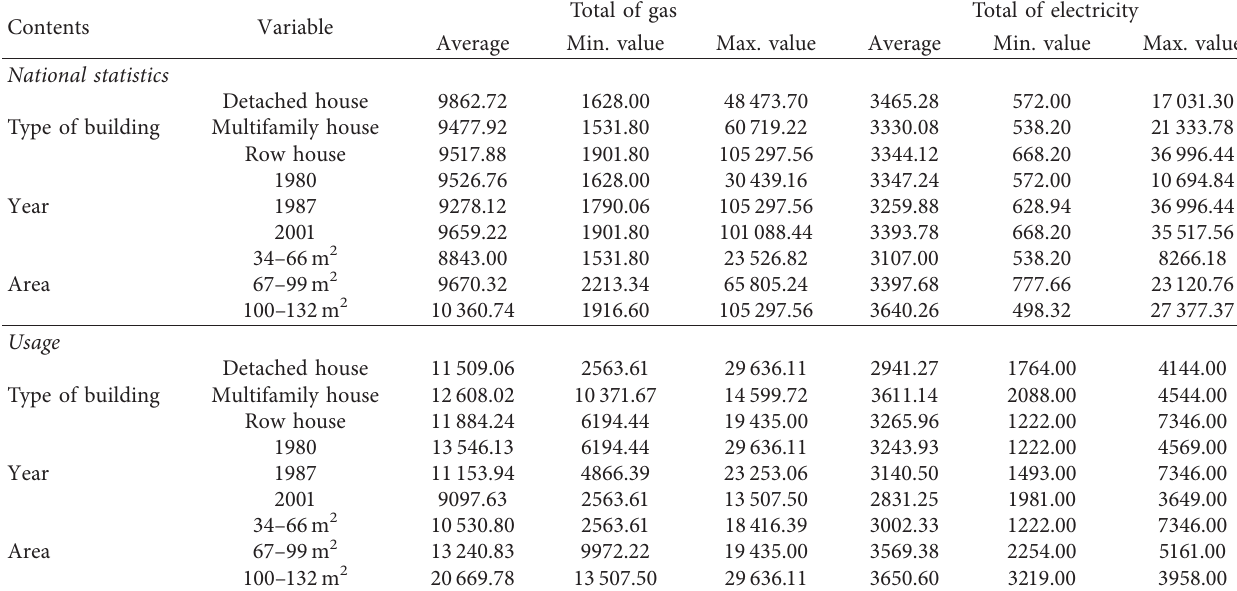
Table 16: Analysis of energy usage comparison: national statistics-usage